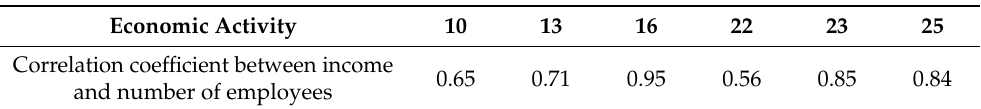
Table 2. Population correlation coefficients between enterprise income and number of employees by the economic